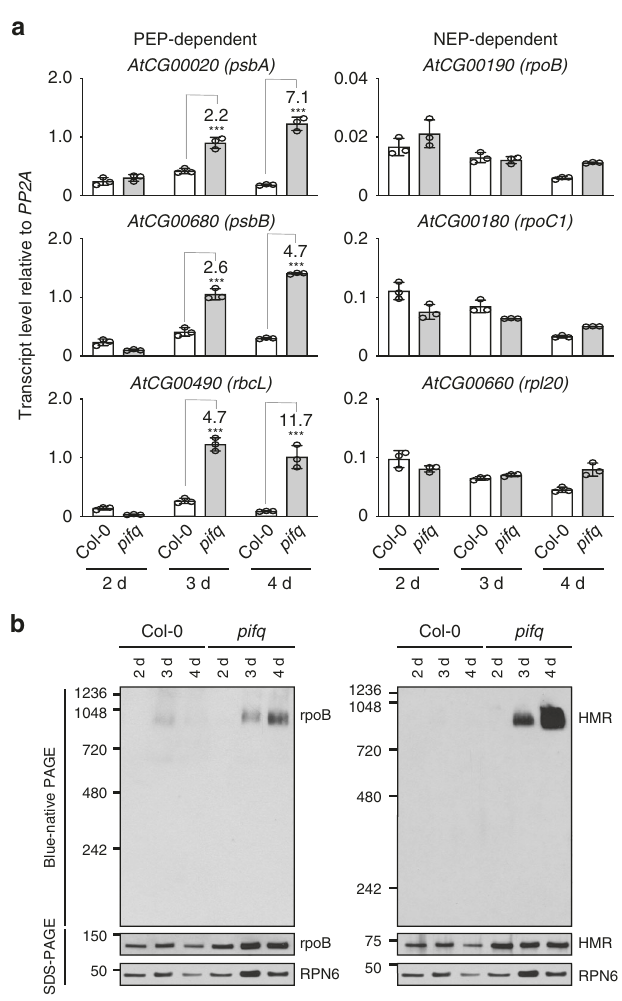
Fig. 5 PIFs repress the assembly and activity of the PEP in the dark. a qRT- PCR results showing the transcript levels of representative PEP- and NEP- dependent genes in 2 – 4-day-old dark-grown Col-0 and pifq seedlings. The transcript levels were calculated relative to those of PP2A . Fold changes are shown only for the pifq samples exhibiting greater than twofold changes compared with the values of the corresponding Col-0 samples (*** p ≤ 0.001). Error bars represent SD of three biological replicates. b Immunoblots showing the level of the PEP complex (blue-native PAGE) as well as the total amount of rpoB and HMR proteins (SDS-PAGE) in 2 – 4- day-old dark-grown Col-0 and pifq seedlings using antibodies against rpoB or HMR. RPN6 was used as a loading control. The source data underlying the qRT-PCR analysis in ( a ) and the immunoblots in ( b ) are provided in the